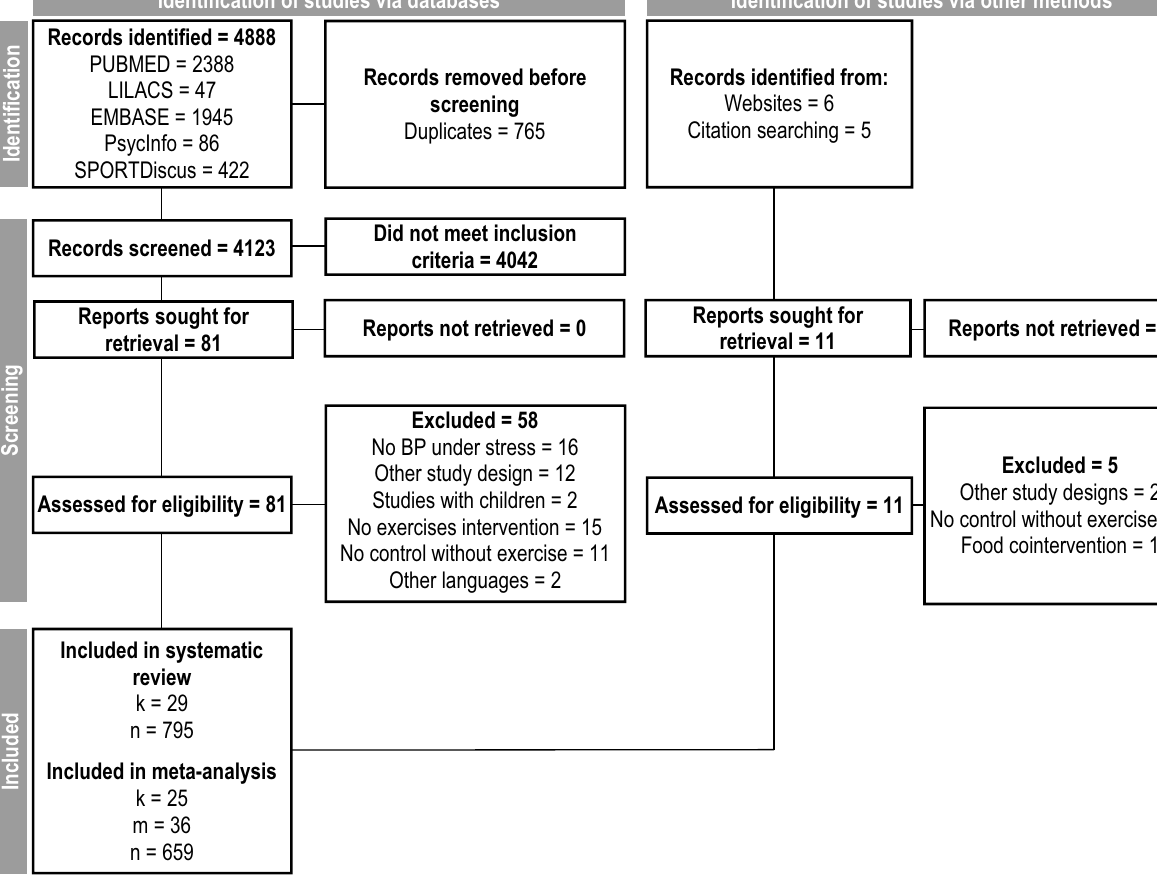
Figure 1. Flow diagram. k, number of studies; n, pooled sample size; BP, blood